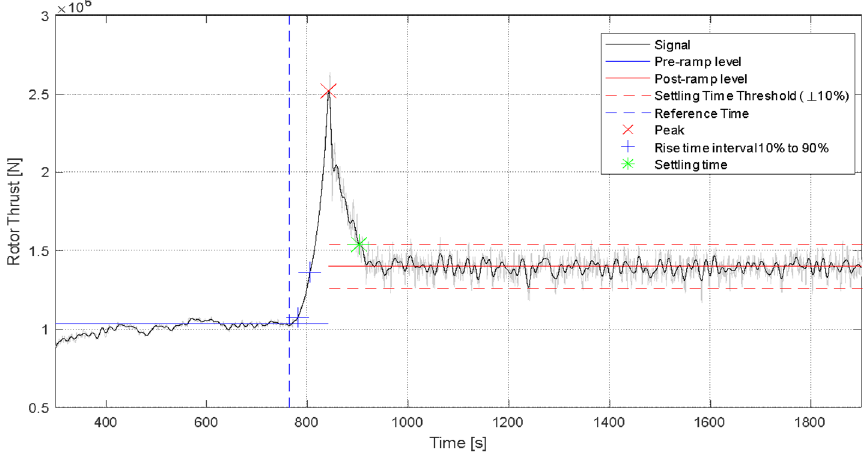
Figure 11. LC 3.2 metric calculation.